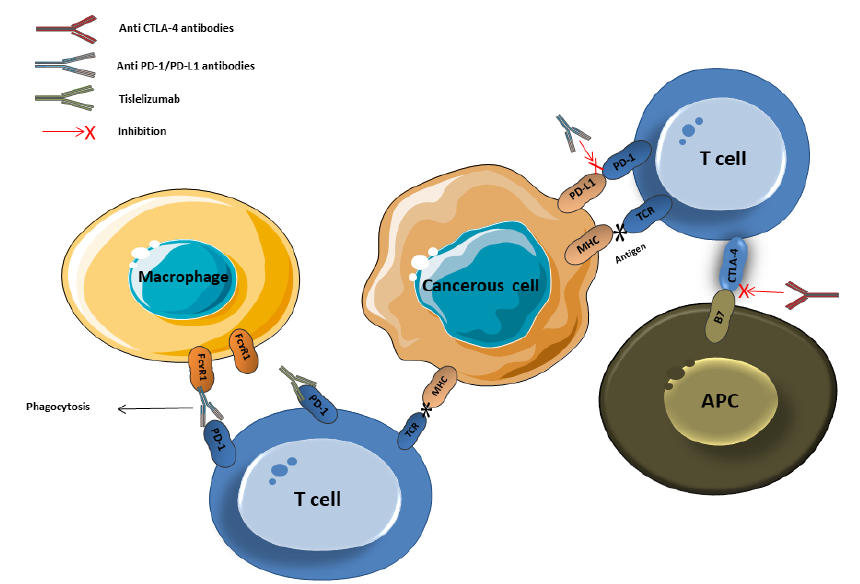
Figure 1. Immune checkpoints inhibitors’ mechanism of action. PD: programmed cell death, CTLA-4: cytotoxic T-lymphocyte associated protein 4, APC: antigen-presenting cell, MHC: major histocompatibility complex, TCR: T cell.